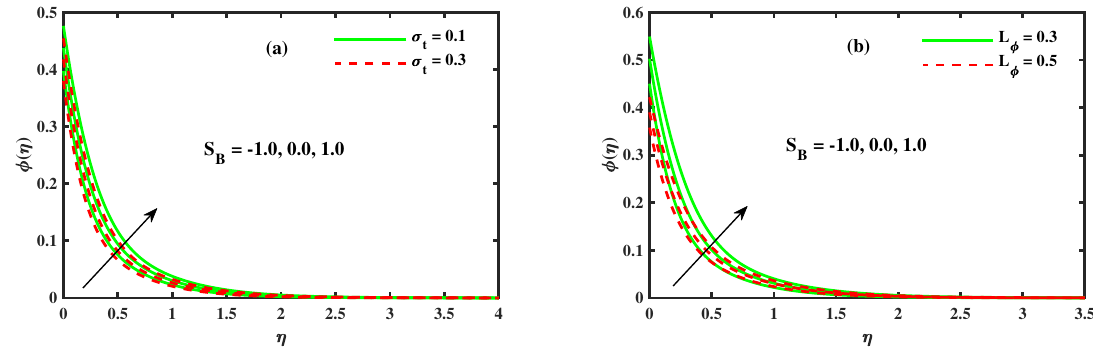
Figure 11. The impact of φ ( η ) for ( a ) unsteady σ t and ( b ) solutal slip L φ .